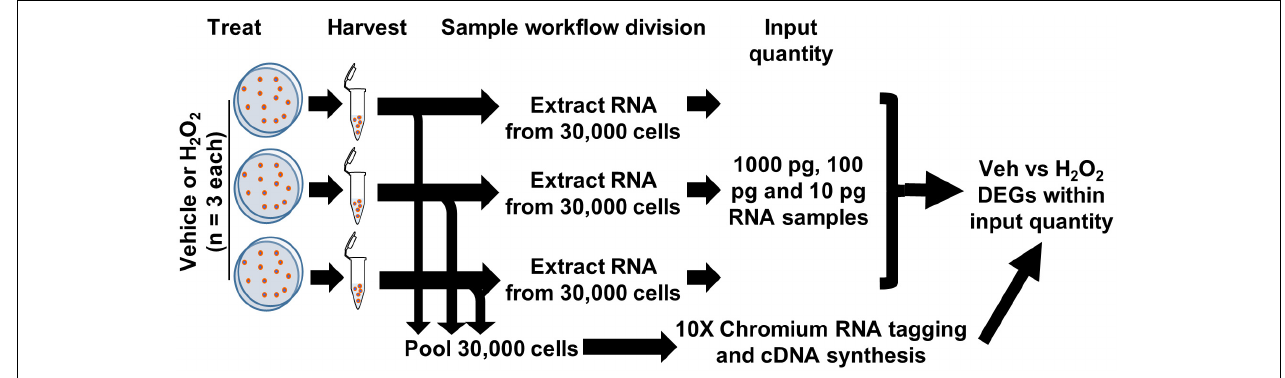
FIGURE 1 | Workflow for cultured NSCs in scRNAseq and bulk RNAseq. NSCs were treated with H 2 O 2 or vehicle in triplicate. 10,000 cells from each biologic replicate were pooled for a total of 30,000 cells applied to the 10 × Chromium scRNAseq platform and subsequent DEG analysis. RNA was extracted from 30,000 cells of each biologic replicate and 10, 100, and 1,000 pg (1 ng) were used in RNAseq with subsequent CLEAR filtering and DEG